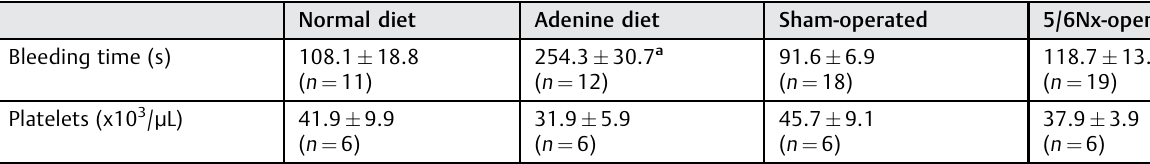
Table 2 Platelet counts and bleeding times in mice Normal